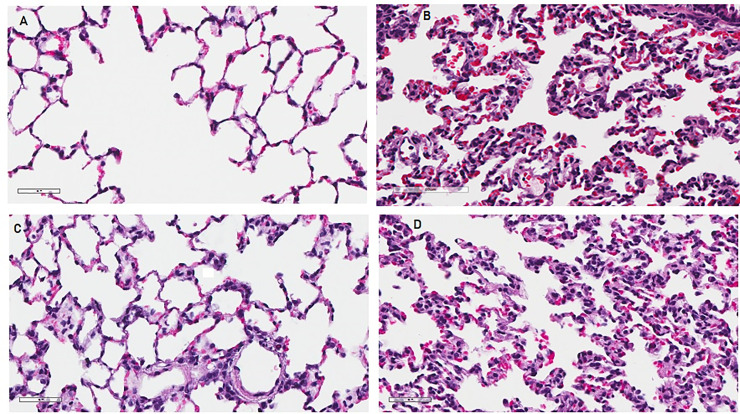
Representative histologic sections of lung taken from rats among various treatment groups.(A) Sham + NDGA surgery group showing normal lung architecture without neutrophilic infiltrate, septal thickening, or hyaline membranes; (B) CLP + vehicle group, showing pronounced septal thickening with significant deposition of hyaline membranes and neutrophilic infiltrate; (C) CLP + NDGA pre-treatment group, showing mild septal thickening, but reduced neutrophilic infiltrate and hyaline deposition; (D) CLP + NDGA post treatment group showing mild to moderate septal thickening with some hyaline membrane deposition and mild neutrophilic infiltrate.